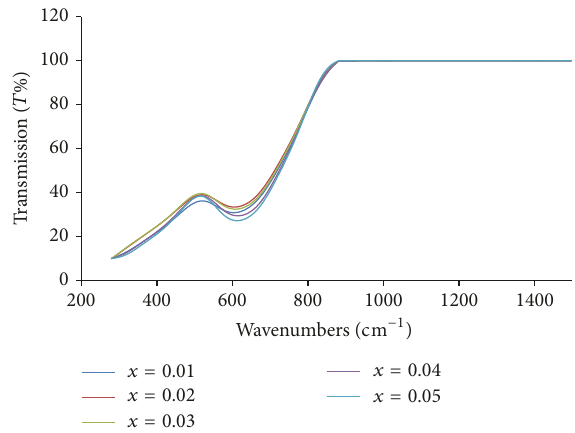
Figure 2: FTIR spectra of [(TeO 2 ) 0.70 (ZnO) 0.30 ] (1−𝑥) (Nd 2 O 3 NPs) (𝑥) glasses.